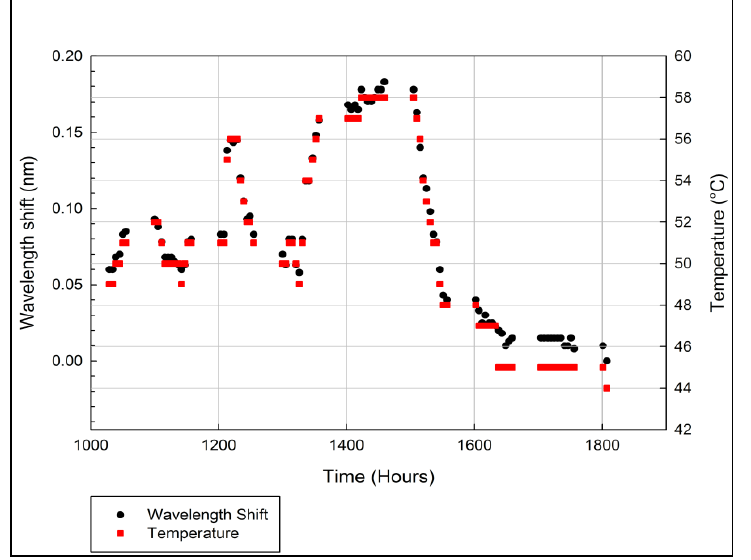
Figure 5. IGBT temperature measurements using FBG-Bimetal temperature